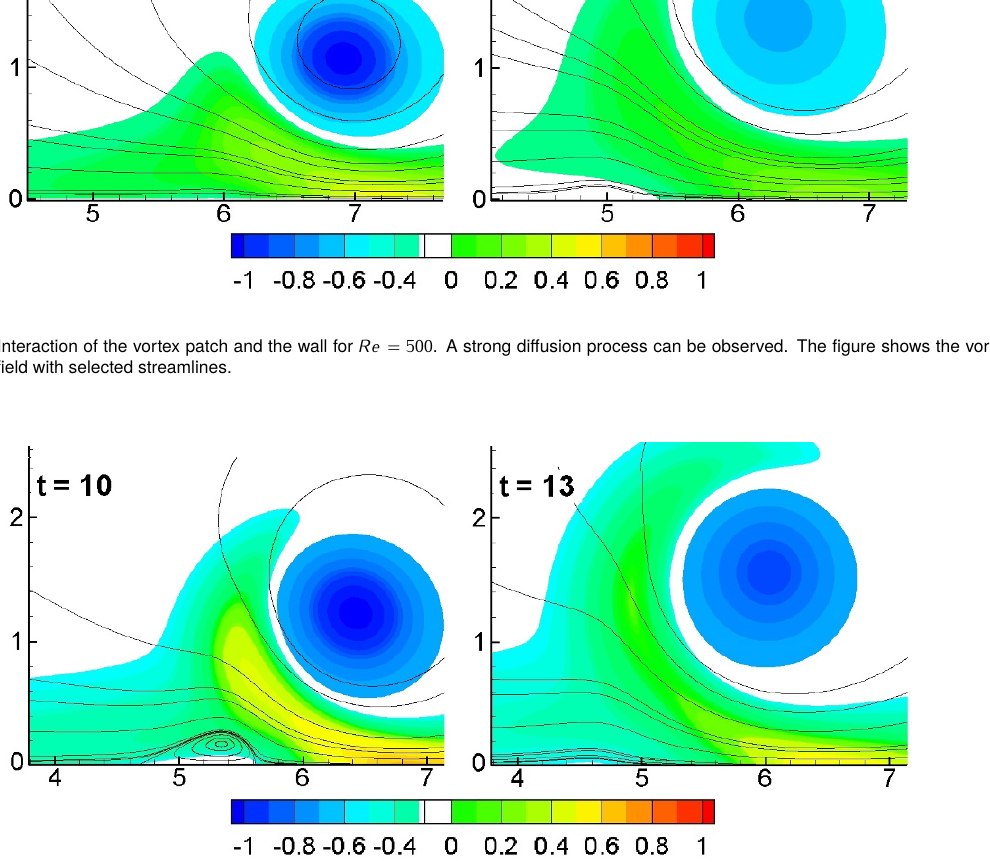
component of the velocity field. Such a pressure gradient slows down the fluid motion, and especially affects the flow behavior close to the wall. For certain values of the Reynolds numbers, this can provoke the appearance of the near-wall recirculation zones, or the boundary layer eruption phenomena.